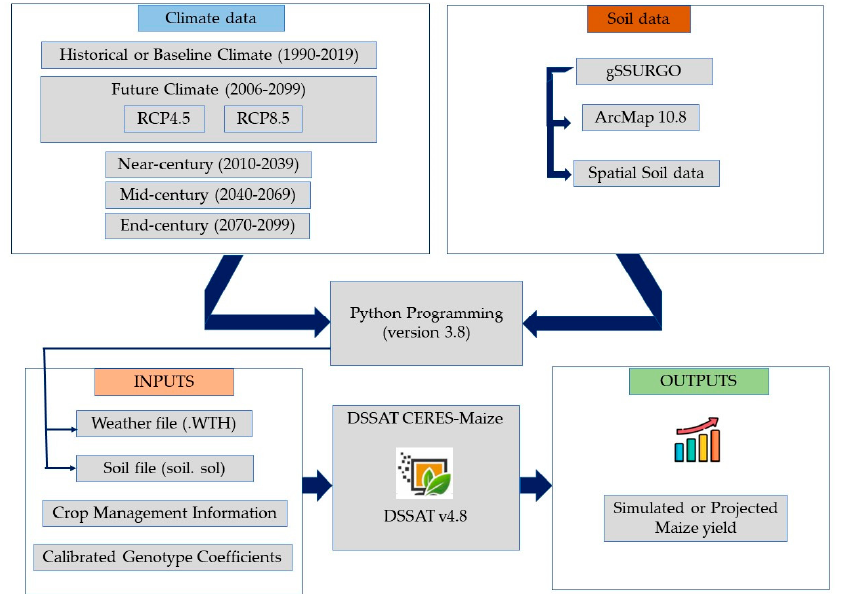
Figure 2. A flowchart illustrating the process of simulating baseline (historic) and projected yields using the DSSAT CERES-Maize model.